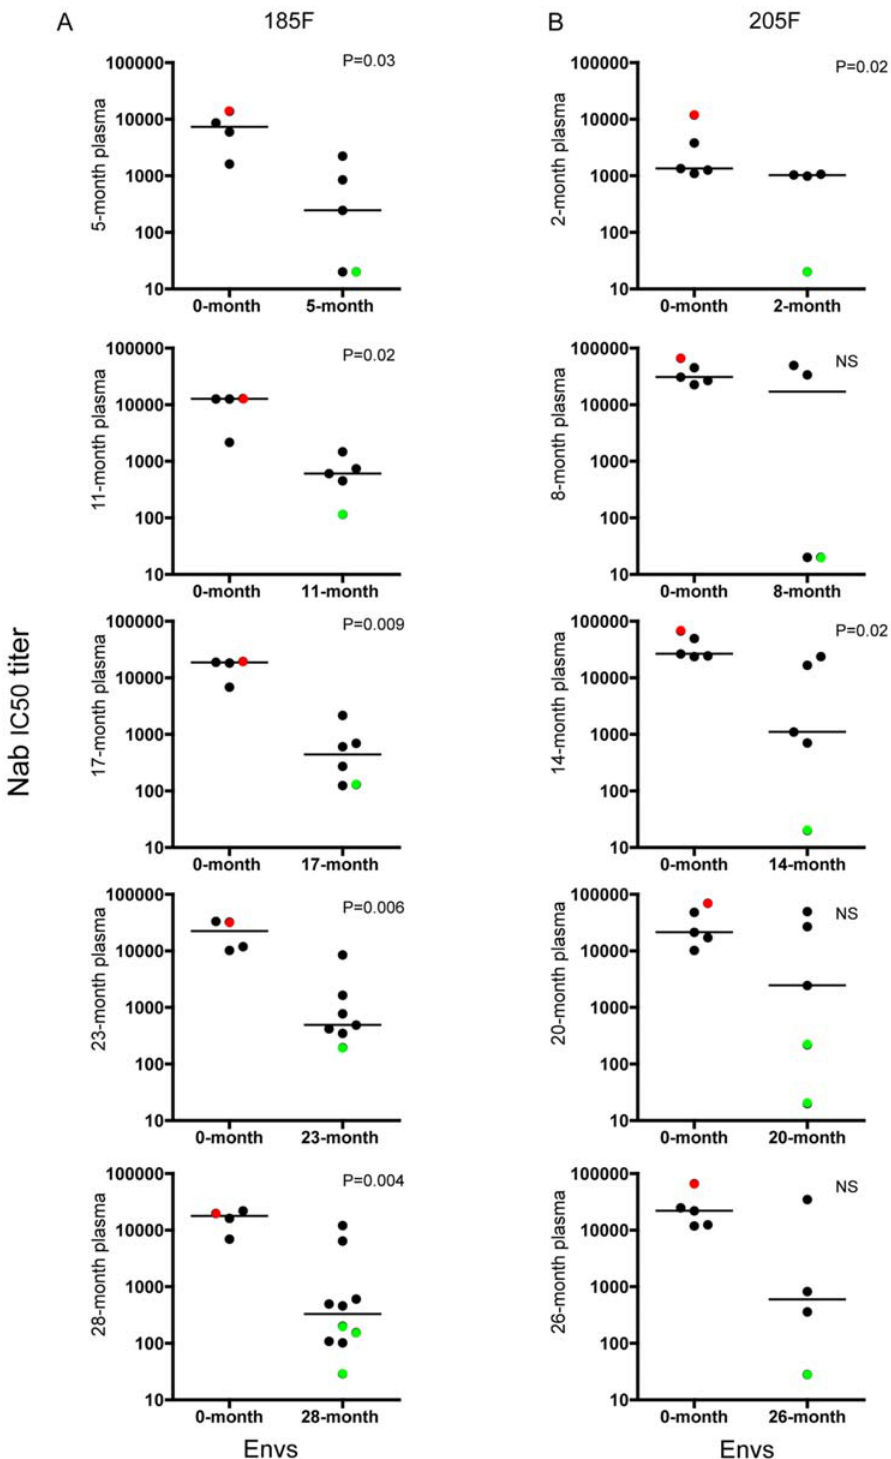
Figure 1. Cycles of escape from autologous Nab in 185F and 205F. Each panel represents a longitudinal plasma sample where Nab activity was evaluated for (A) subject 185F (5, 11, 17, 23, and 28 months) or (B) subject 205F (2, 8, 14, 20, and 26 months). Each data point represents the Nab IC50 titer (shown on the vertical axis on a log10 scale) for a single plasma-Env combination calculated from the virus infectivity curve using the Excel growth function. The Nab IC50 titers against the 0-month Envs and the contemporaneous Envs are shown for each longitudinal plasma sample (labeled along the vertical axis), and the horizontal bars indicate the median for each group of Envs. A Mann-whitney analysis was used to test for statistically significant differences between the Nab sensitivity of the 0-month and contemporaneous Envs, and p-values less than 0.05 were considered significant. Red dots indicate the Nab IC50 titer for 0-month Env that was used as a background for the chimeras. Green dots indicate the Nab resistant Envs from each time point that were selected and used to generate the chimeras.